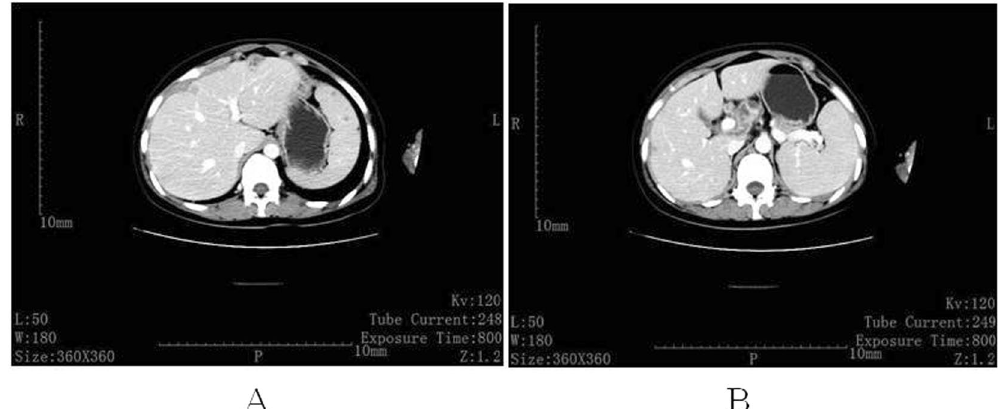
Figure 1. Abdominal enhanced CT of case 18. ( A ) Irregular thickness of the peritoneum and local nodular shape protruding to the liver surface; multiple nodules in the liver surface, with uneven enhancement and multiple local necrosis; larger in the spleen, with small circular low density and slight enhancement. ( B ) Multiple enlarged lymphoglandulae coeliacae coalescing partly and annular enhanced lesions, and low density shadow in the local